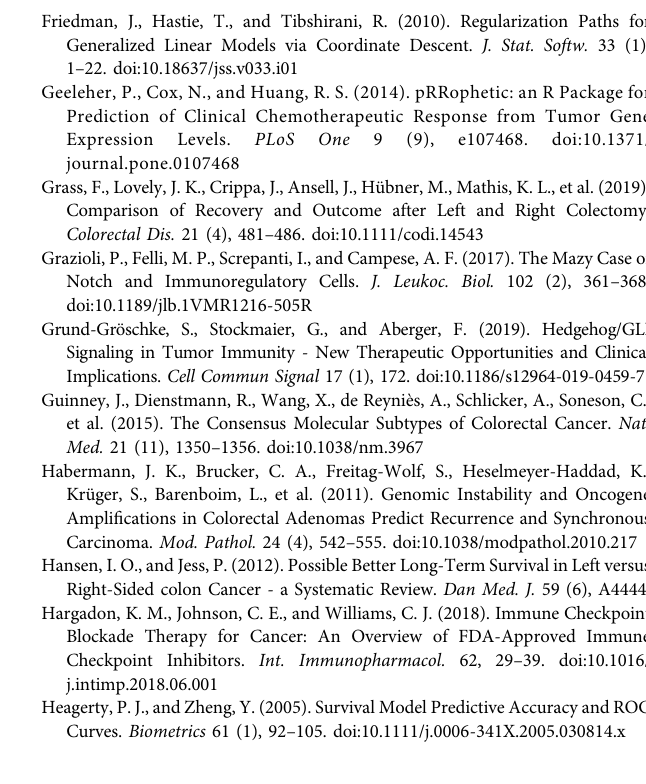
Supplementary Figure S1 | Overall fl owchart of this study. Supplementary Figure S2 | (A) In order to achieve a scale-free co-expression network, we chose power index (cid:1) 3 as the appropriate soft threshold. (B) Identi fi cation of a co-expression module. The branches of the dendrogram correspond to 6 different gene modules. Supplementary Figure S3 | Kaplan-Meier curves of HRG and LRG were plotted through strati fi cation of different clinical factors. Supplementary Figure S4 | The differences of CNSMs between HRG and